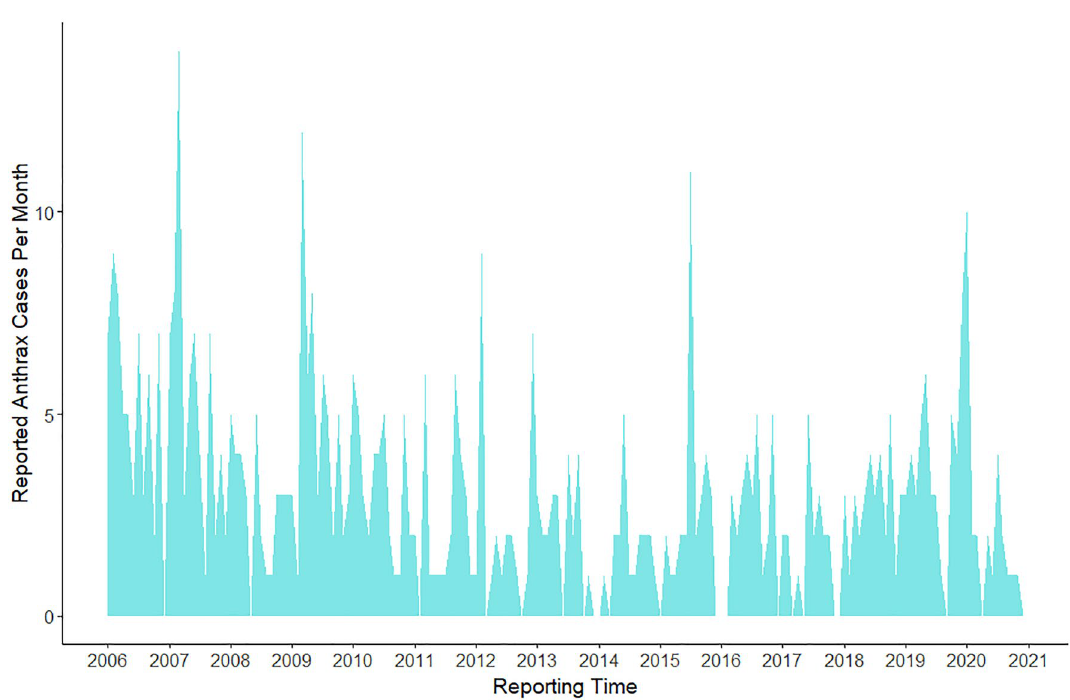
Figure 8. Temporal trends in country-wide livestock anthrax cases from 2006 to 2020. The polygon height illustrates the monthly total livestock cases reported across Kenya. The full anthrax case time series was assembled from the Kenya Directorate of Veterinary Services: Monthly case reports from 2006 to 2020. Full details of reporting procedures and case definitions are provided in Methods. The figure was generated using R software v. 4.1.0 28